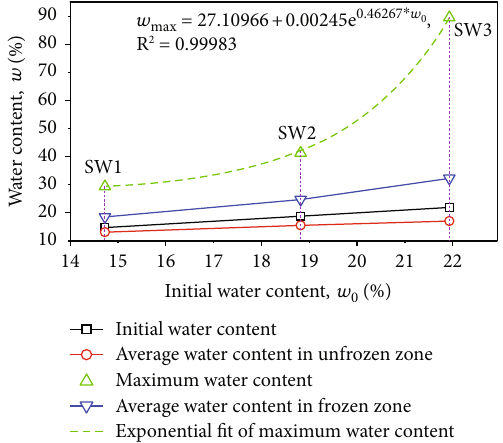
Figure 13: Change law of water content in the samples before and after